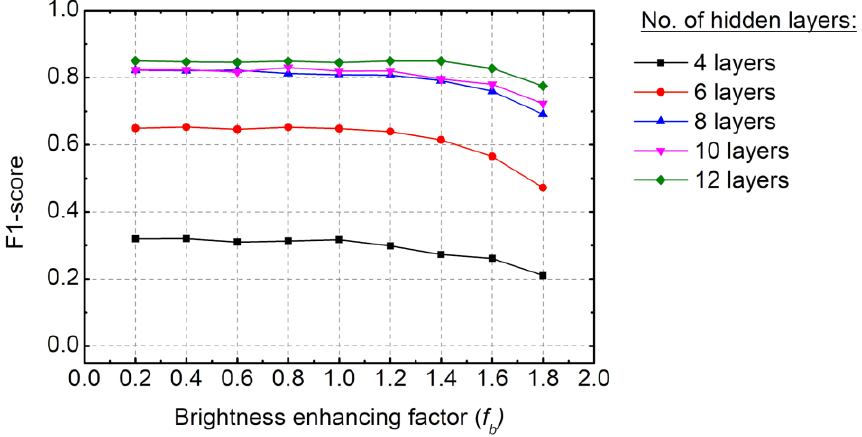
Figure 12. Improved F1-score on applying the image preprocessing model.